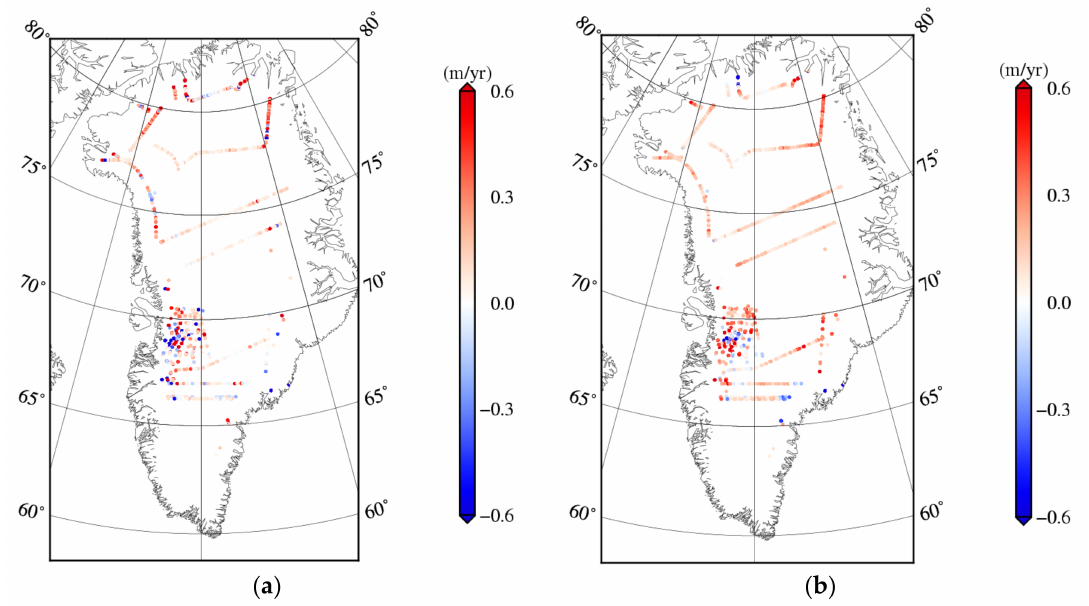
Figure 5. Elevation changes differences between the OIB ATM L4 data and SARAL and CryoSat-2 for 2013–2015. ( a ) The comparison between OIB ATM L4 data and SARAL. ( b ) The comparison between ATM L4 data and